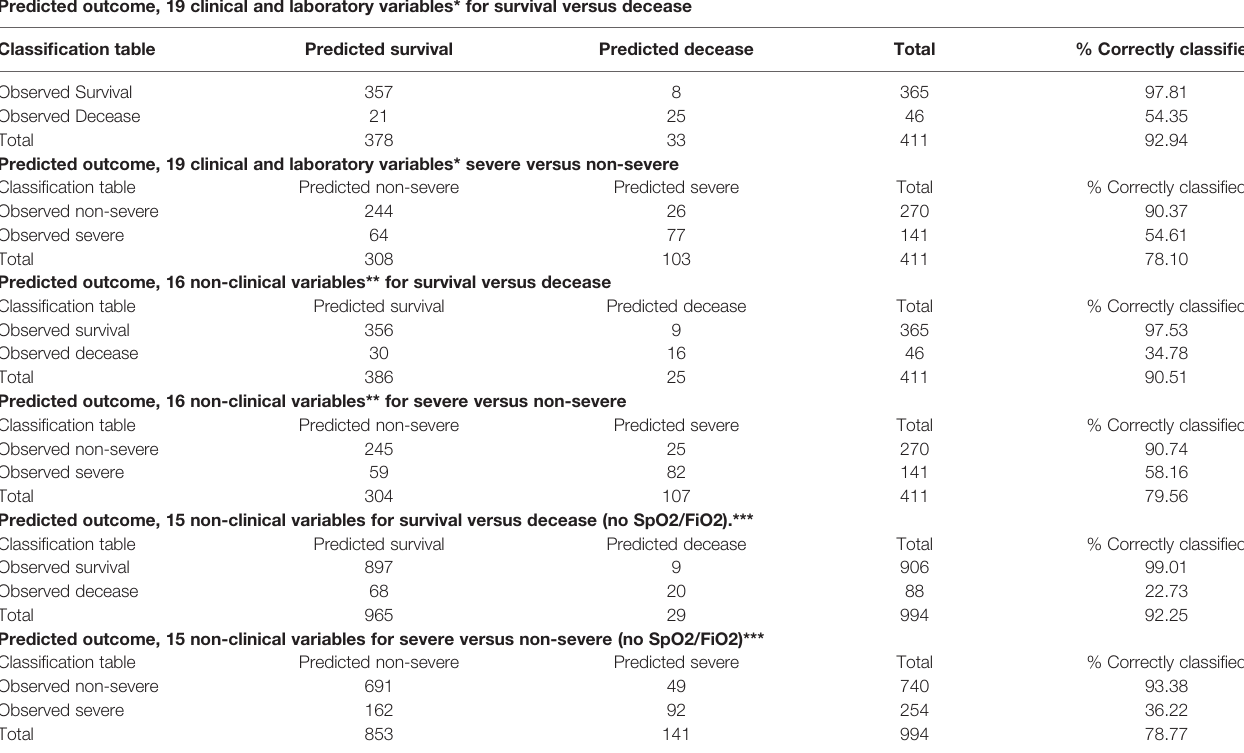
TABLE 3 | Classi fi cation tables from multiple logistic regression including different sets of variables for survival vs decease or severe vs non-severe as outcome. Predicted outcome, 19 clinical and laboratory variables* for survival versus decease Classi fi cation